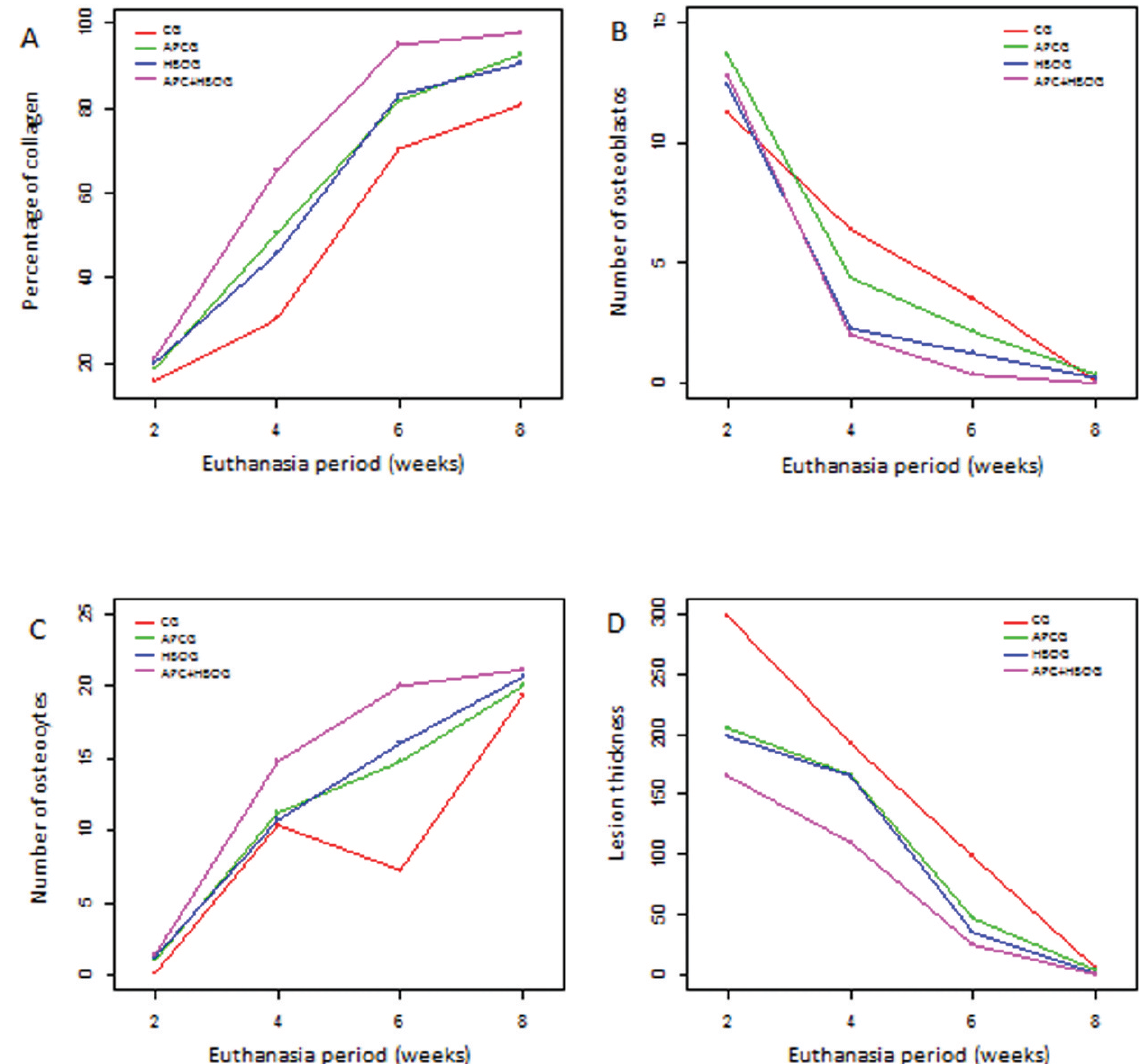
Figure 1 - Distribution of the average percentage of collagen (A), average number of osteoblasts (B) and osteocytes (C), and average lesion thickness (D), according to groups and euthanasia periods